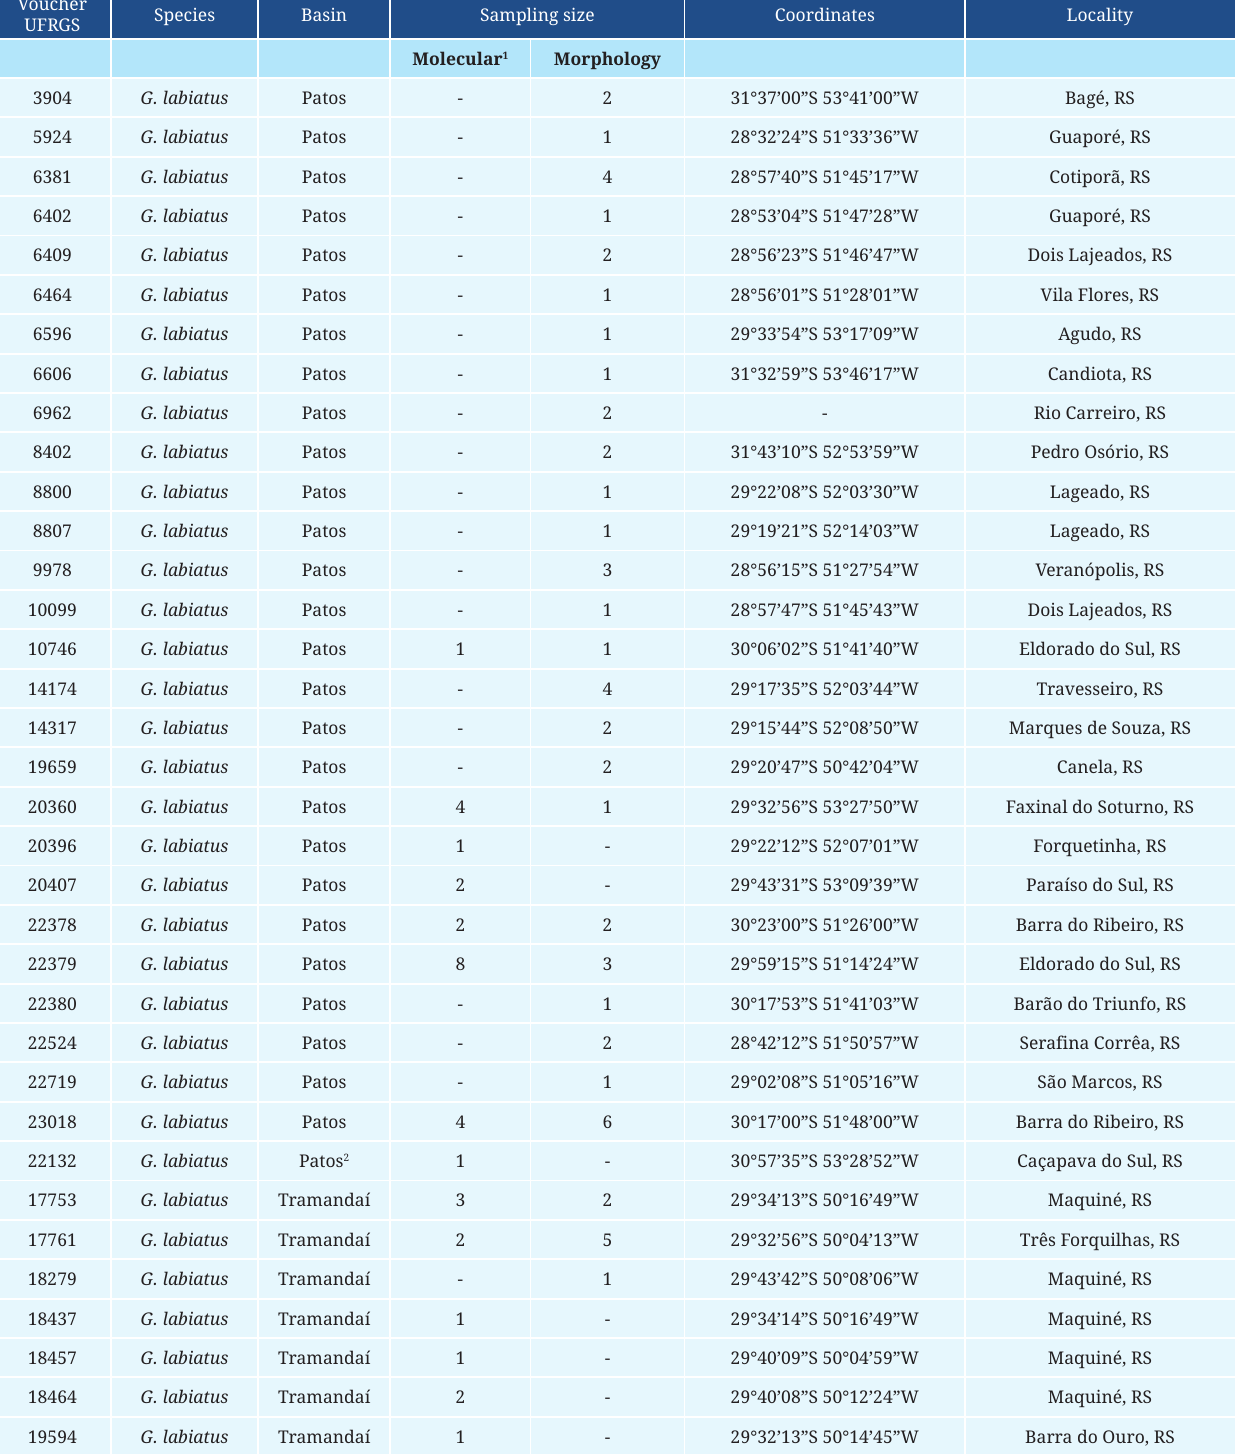
TABLE 1 | Individuals and locations of Gymnogeophagus labiatus and G. lacustris included in the present study. 1 Sample size for the molecular markers consider individuals characterized for both cytB and D-loop . 2 Located in the Camaquã River sub-basin. Voucher